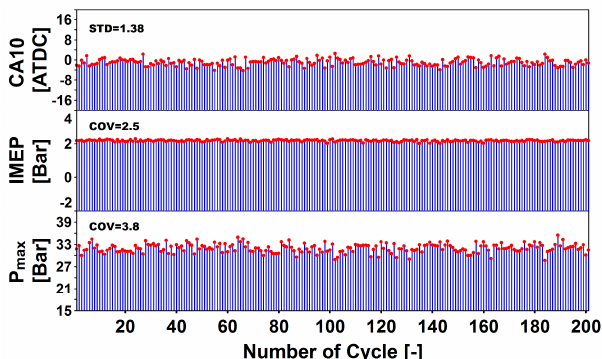
Figure 6. Cyclic variation of CA10, IMEP and P max in conventional operation (rpm = 3000, IMEP = 2.1 bar, T epc = 385 K, In-EGR = 0, Ex-EGR = 0).